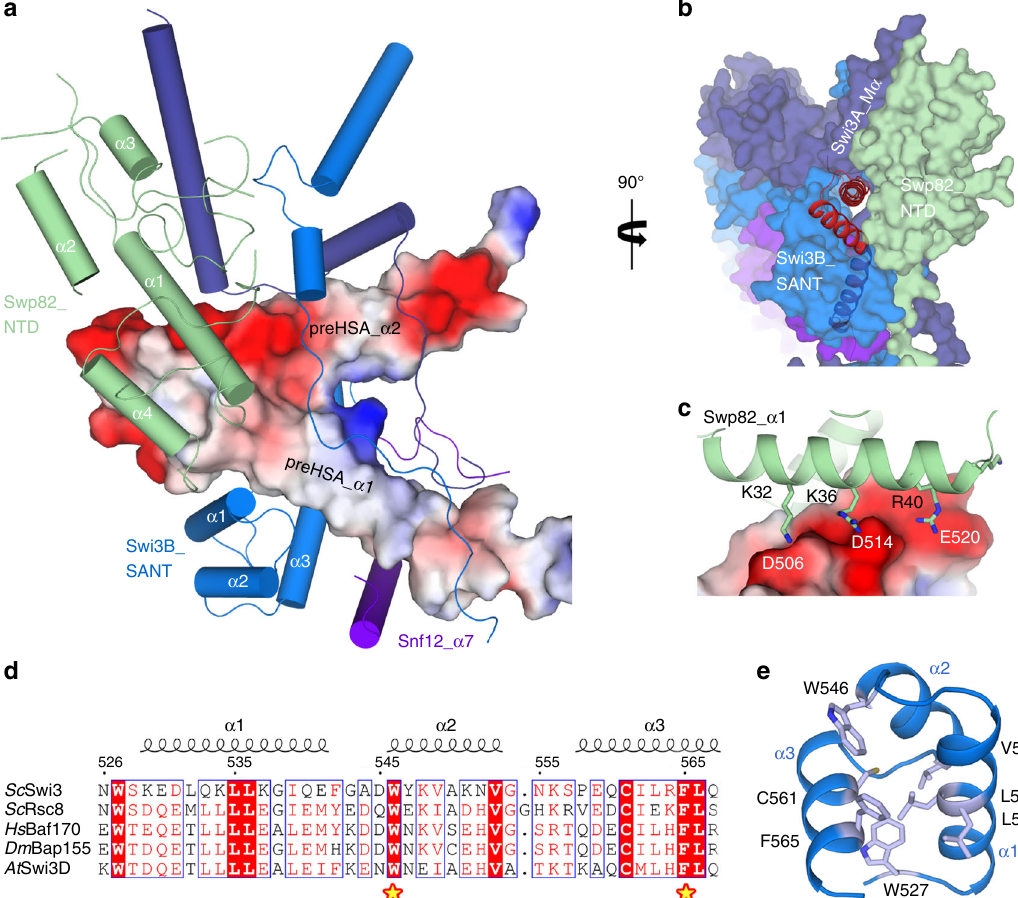
Fig. 4 Stabilization of preHSA domain. a Front view of the PS module. The preHSA domain is shown as an electrostatic potential map (blue and red colors represent positive and negative charges, respectively), and the surrounding protein elements are shown in cartoon representation. b Side view of the PS module. c Close-up view of the interface between Swp82_ α 1 and preHSA. Key residues are labeled. d Sequence alignment of SANT domains of SWI/SNF complexes from different species. Sc Saccharomyces cerevisiae , Hs Homo sapiens , Dm Drosophila melanogaster , At Arabidopsis thaliana . e The structure of SANT_B with conserved hydrophobic residues shown in stick